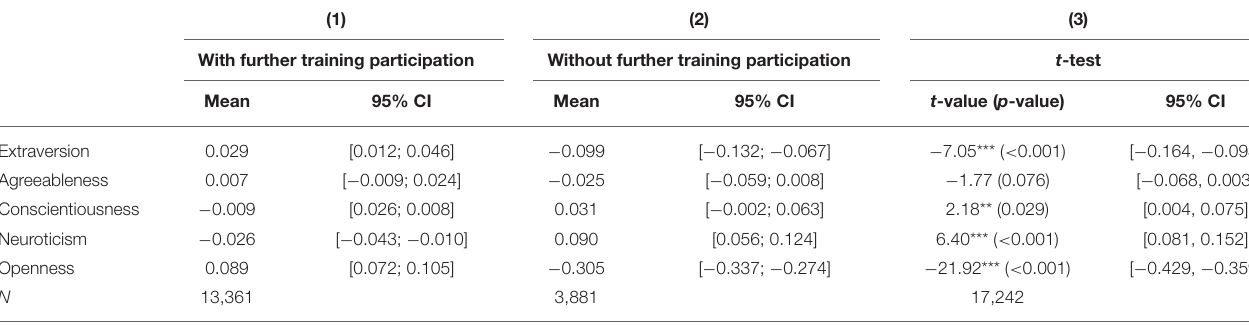
TABLE 5 | Standardized, age-corrected Big Five Personality Dimensions of further training participants and of non-participants. (1)